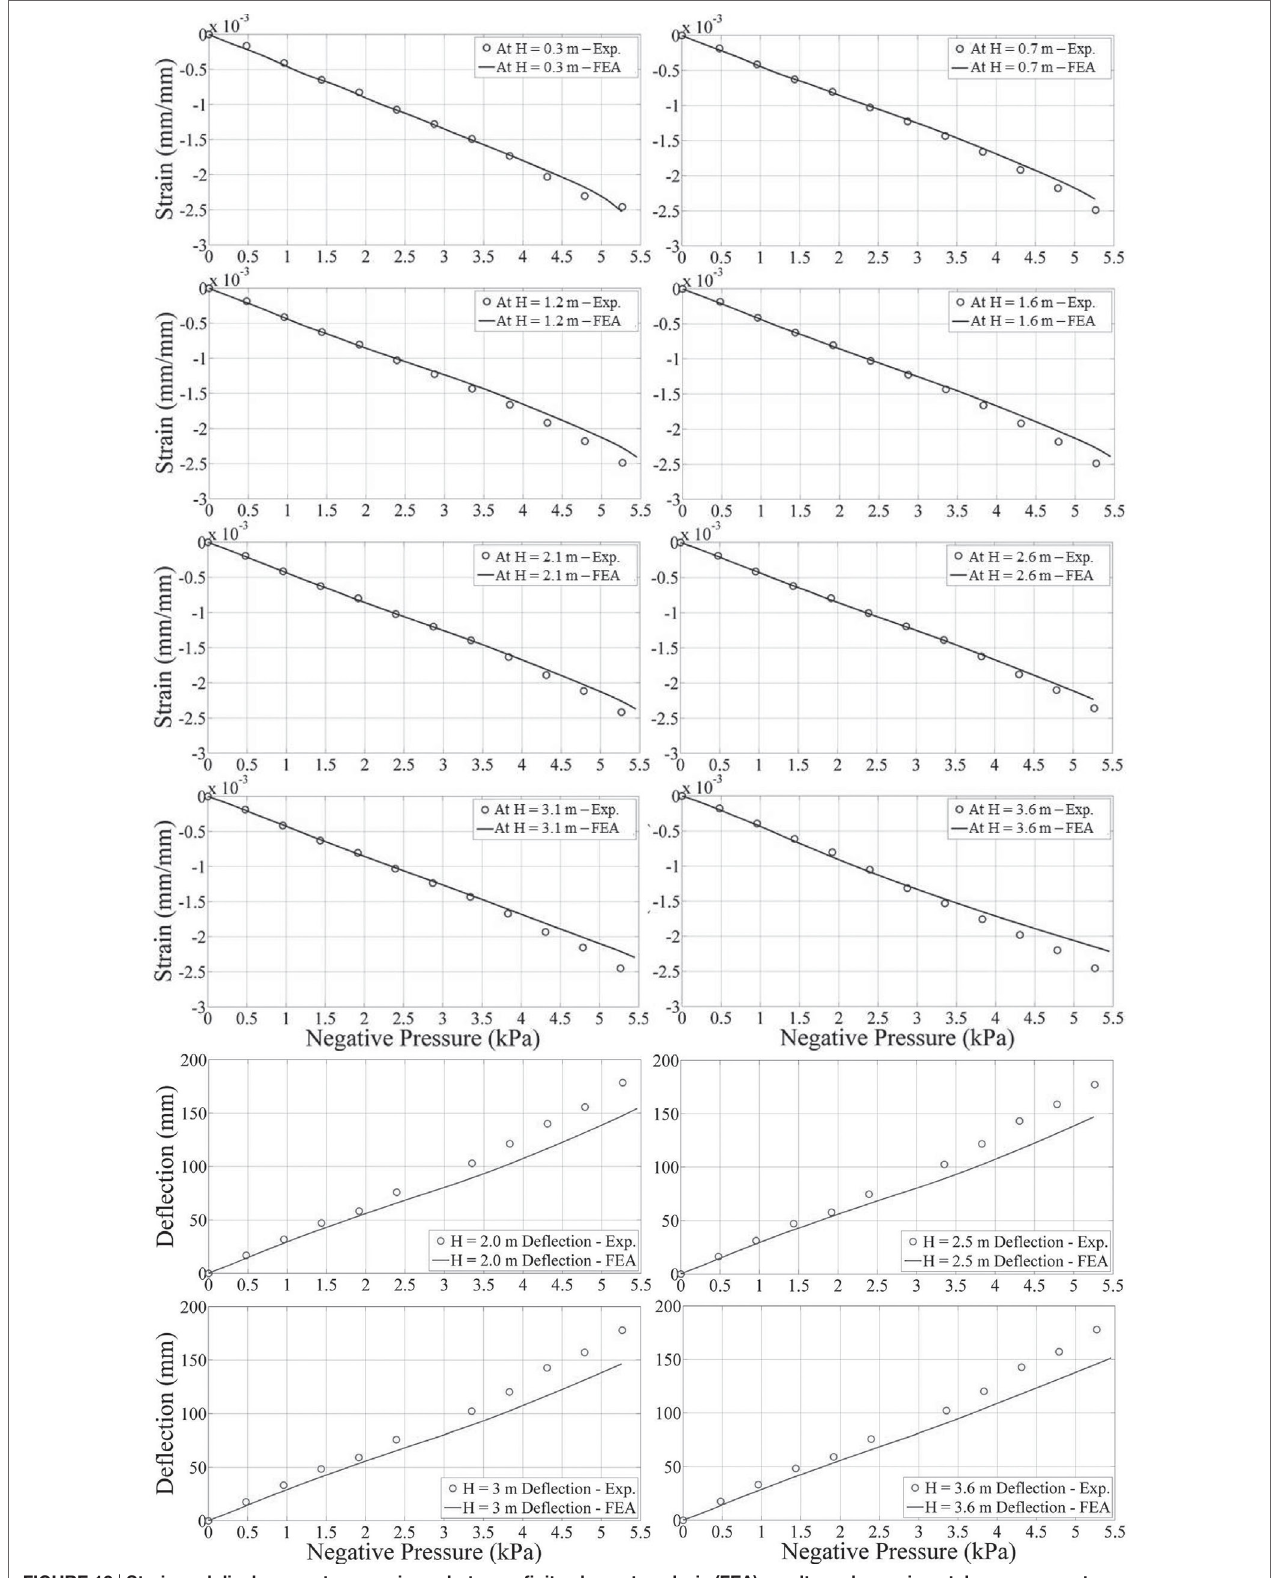
FigUre 12 | strain and displacement comparisons between finite element analysis (Fea) results and experimental measurements